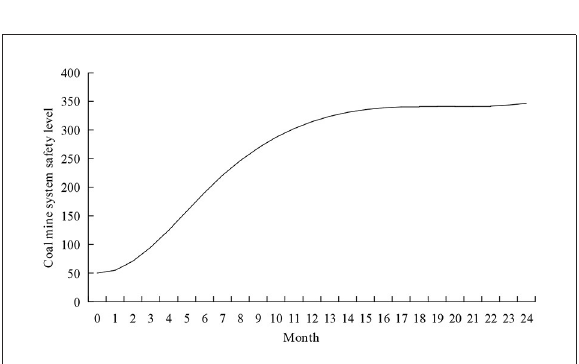
FIGURE7 Initial simulation results of coal mine system safety